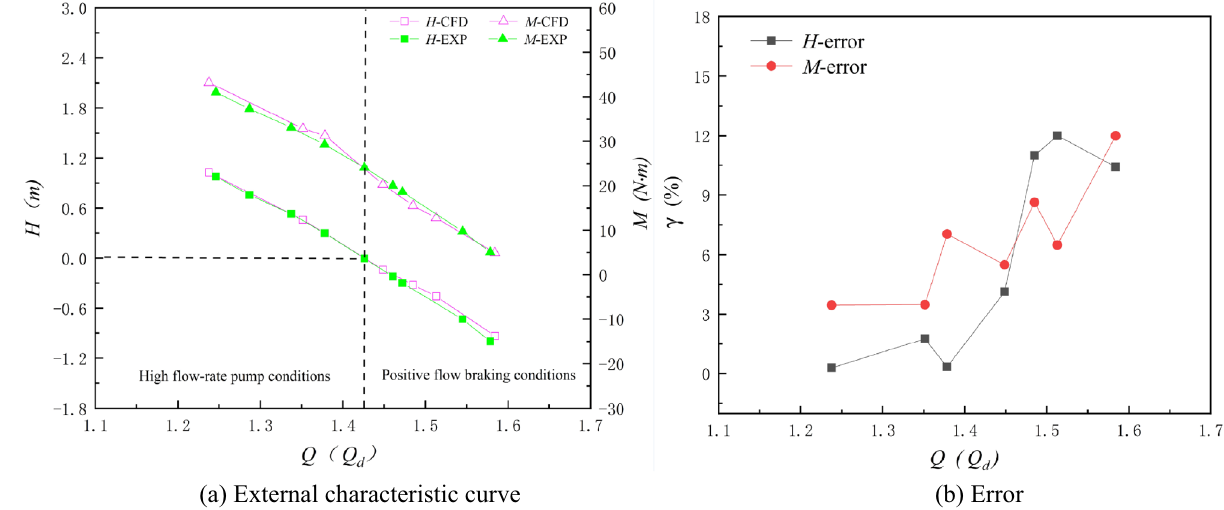
Figure 20. Comparison of numerical simulation results and experimental results of the NZHC.